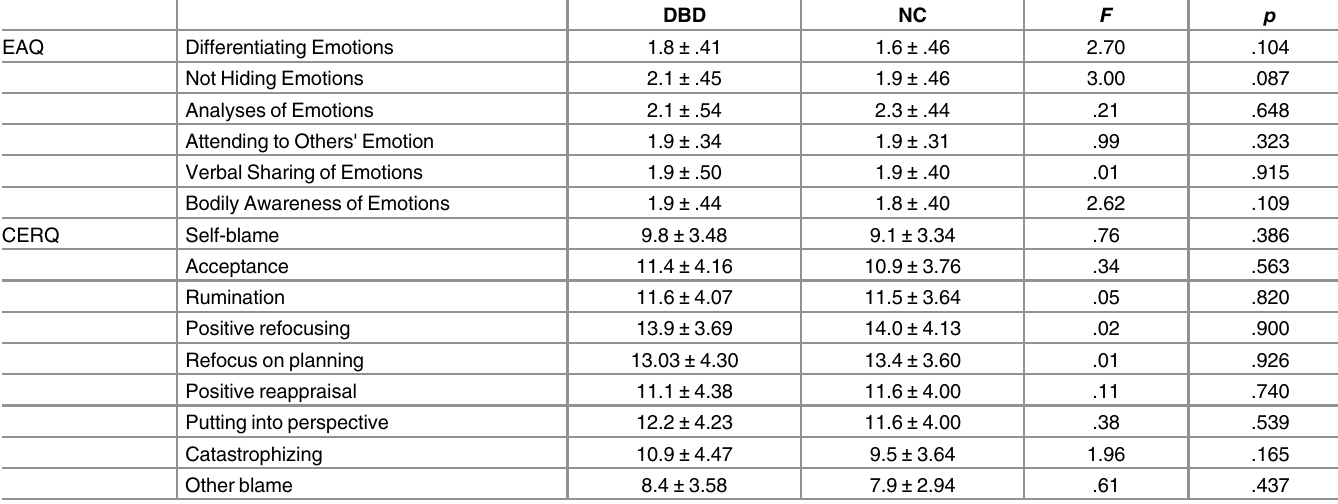
Table 1. Emotional awareness and cognitive emotion regulation in the ODD/CD (n = 61) and NC group (n =